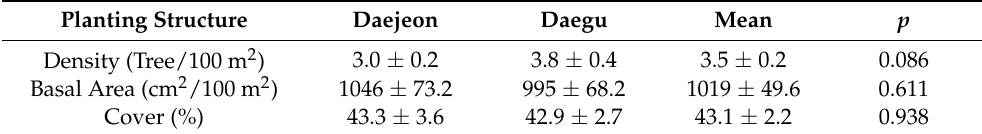
Table 4. Tree planting structures in the study parks.